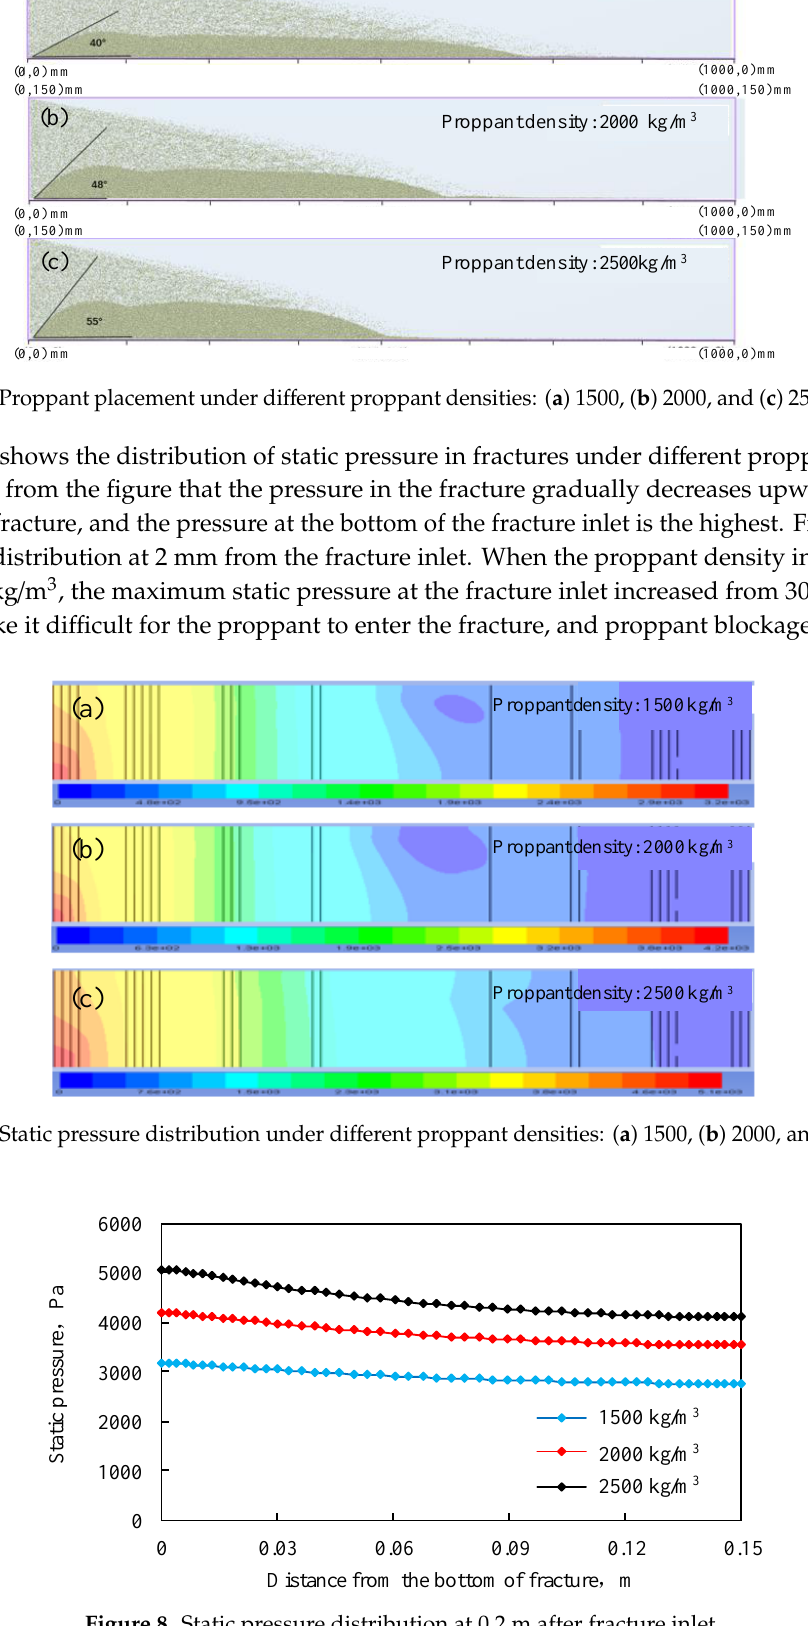
Figure 8. Static pressure distribution at 0.2 m after fracture inlet.